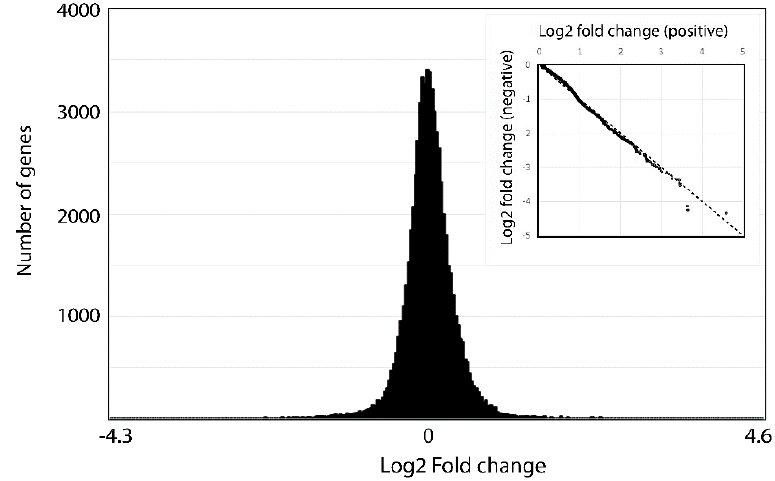
Figure 5. Fold changes are equally distributed. A histogram showing of the number of times a given log2 fold change is found in the data shows a normal distribution. The inset, showing a plot of the positive vs. negative log2 fold changes, is essentially an unbiased straight line indicating few genes are differentially expressed at one of the two times.